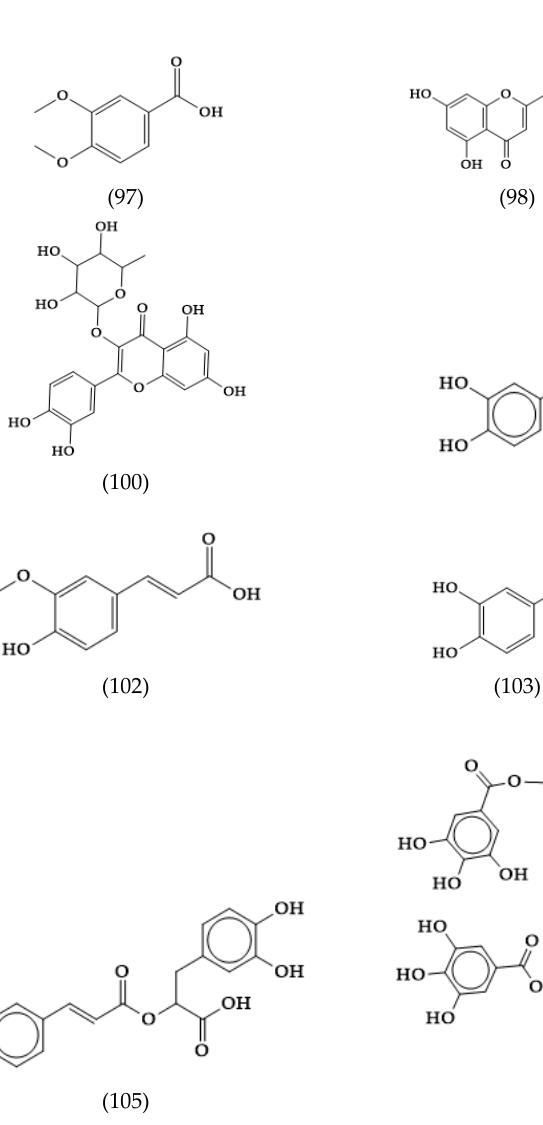
Figure 15. Other phytoconstituents in Veronica spicata .